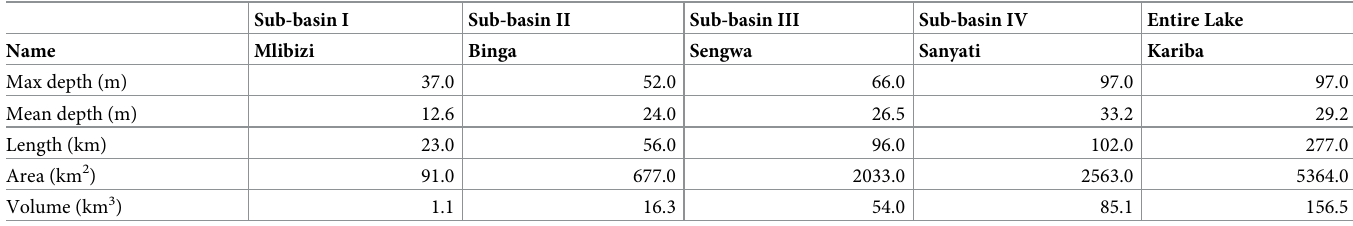
Table 1. Properties of the four sub-basins of Lake Kariba. List of main properties of the four sub-basins and the entire lake for the lake level of 485 m a.s.l. [26,31]. Sub-basin